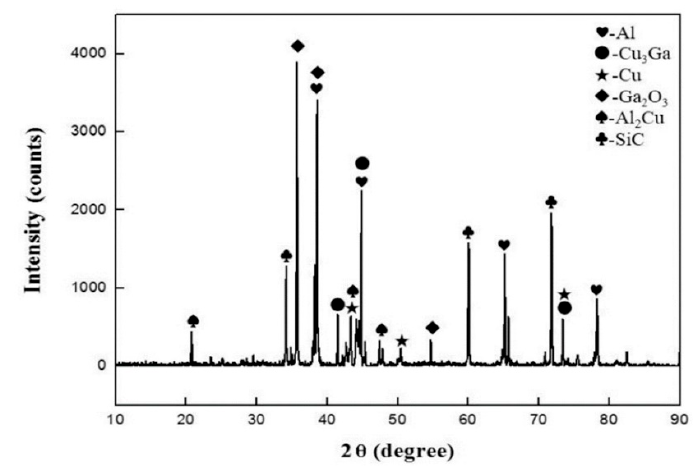
Figure 10. X-ray diffraction XRD analysis of the joint fracture made using liquid gallium with nano- Figure 10. X-ray di ff raction XRD analysis of the joint fracture made using liquid gallium with copper particles at 450 °C. nano-copper particles at 450 ◦ C.